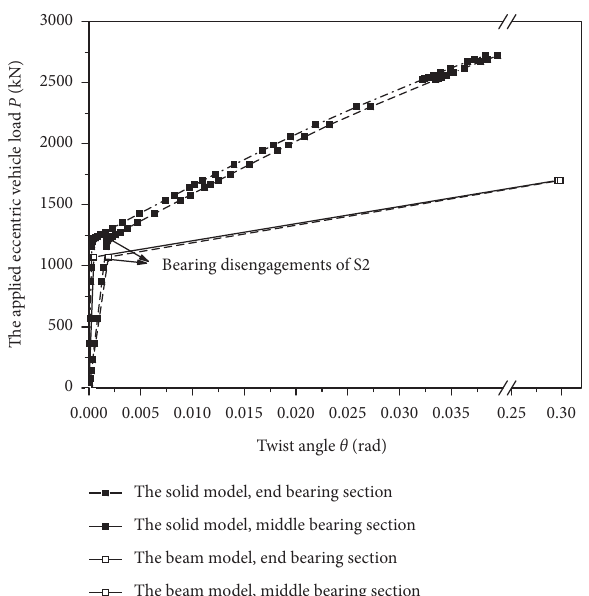
Figure 11: Applied load-twist angle relationships calculated from the beam and solid